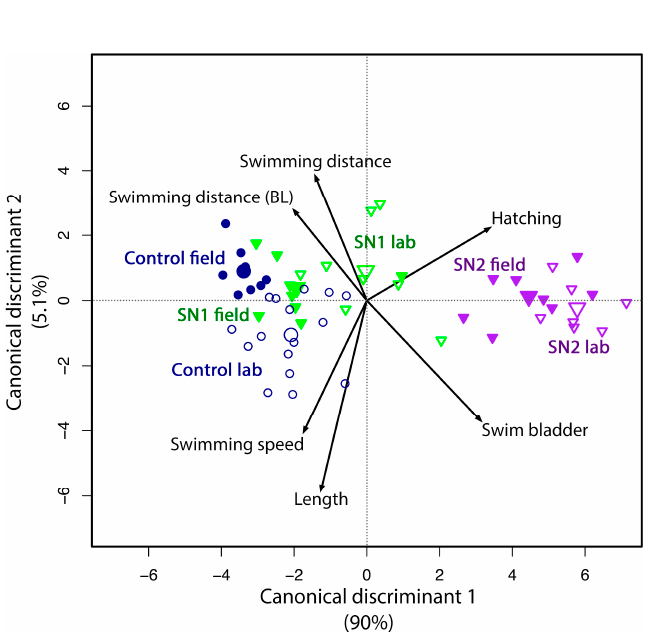
Figure 4. Canonical discriminant analysis of the results of the experiment with field water and the reconstituted mixtures. Small symbols represent the sample scores, and large symbols represent the average scores per experimental group. Filled symbols represent samples of the field experiment and open symbols represent samples of the reconstituted experiment. Control field and control lab represent standard embryo medium. Length, swimming distance and speed are positive effects (i.e., higher values are better), while hatching and swim bladder represent impaired hatching and impaired swim bladder inflation, which are adverse effects.